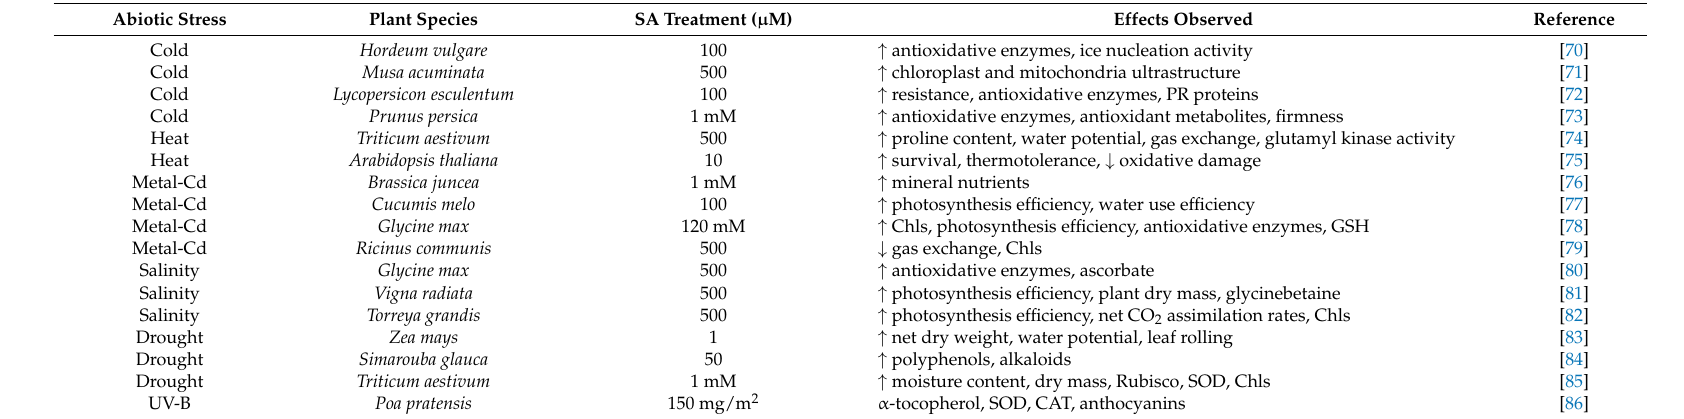
Table 3. Effects of SA in abiotic stress